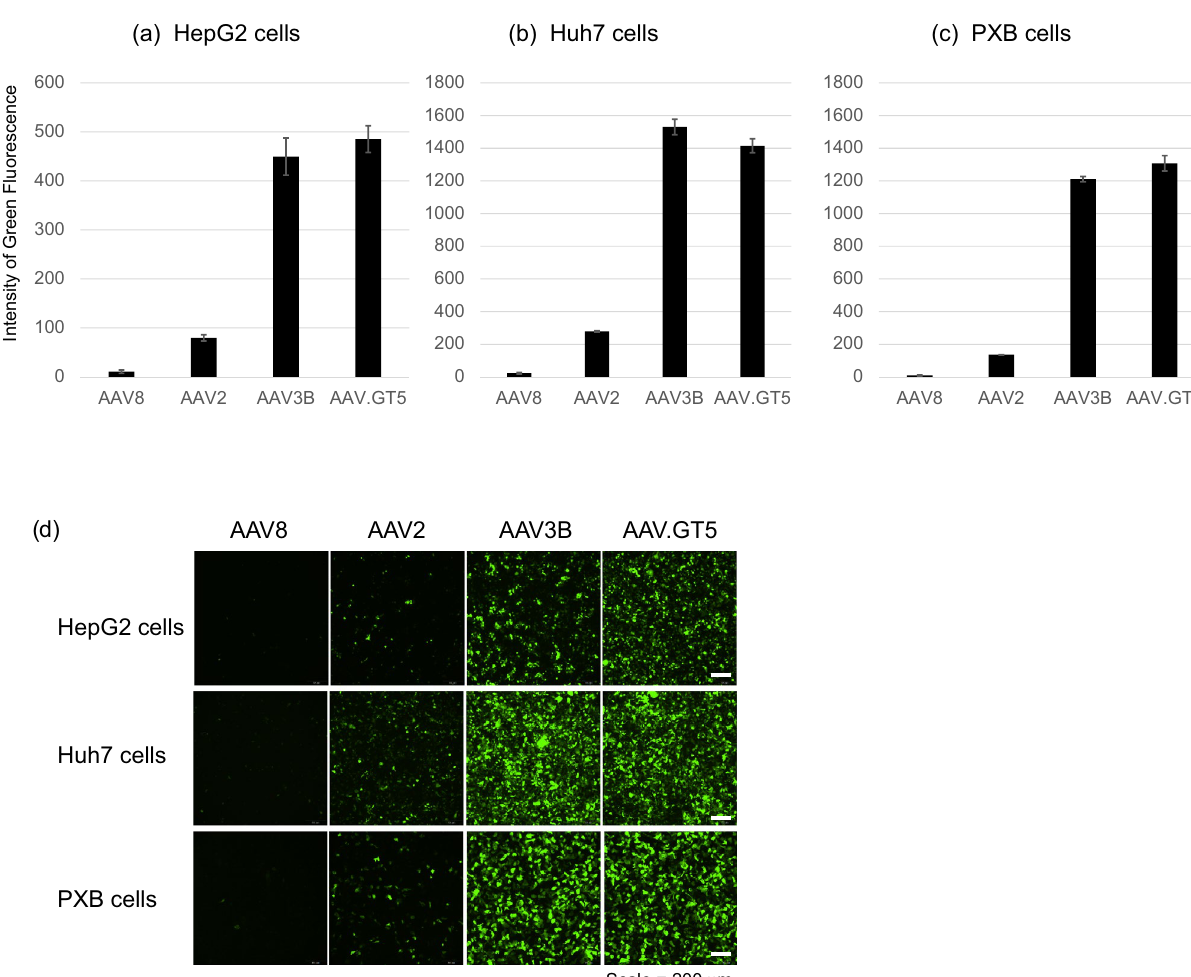
Figure 2. Transduction efficiency of AAV8, AAV2, AV3B, and AAV.GT5 on human hepatocytes. Seven days after the infection of green fluorescence protein (GFP)-expressing AAV vectors at the 10 4 of multiplicity of infection, mean fluorescence intensity (MFI) of GFP were measured. ( a ) HepG2 cells, ( b ) Huh7 cells, ( c ) PXB cells. The scale of the vertical axis is different for each cell-line. ( d ) Representative images. Scale bar represents 200